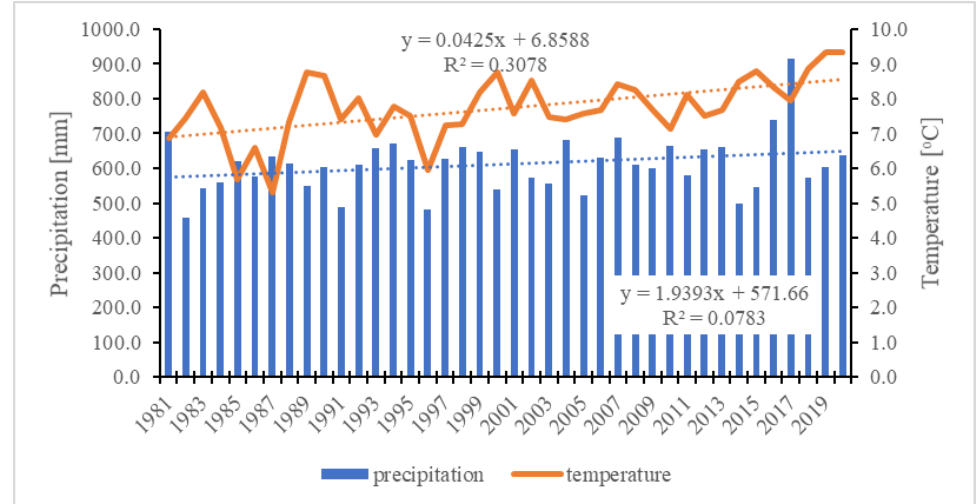
Figure 2. The value of the average annual air temperature and sum of precipitation in the years 1981–2020 (area average for Braniewo poviat).